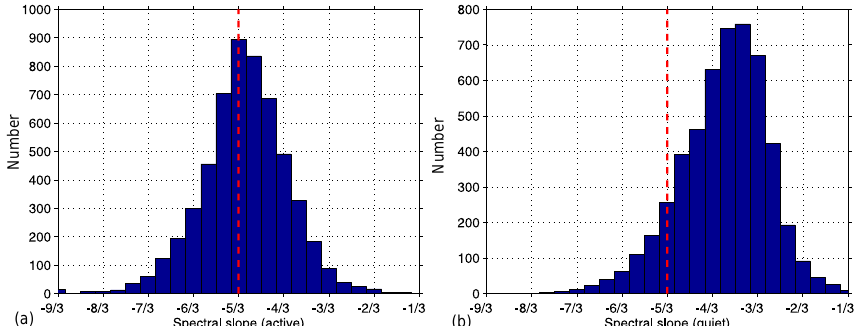
Figure 6. Histograms of spectra of vertical wind velocity during active (a) and quiet periods (b) . The theoretical − 5/3 spectral slope is indicated by the red dashed